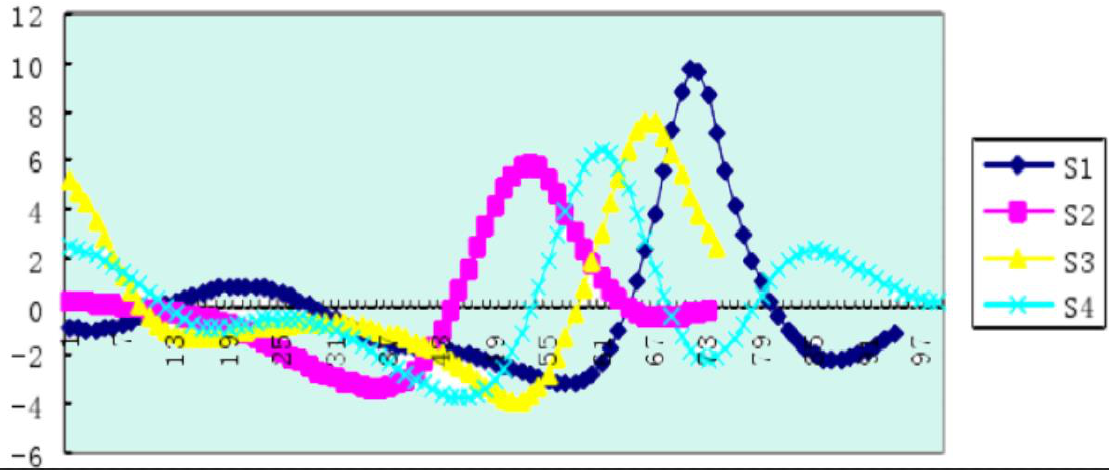
Figure 9. The curve of the angular velocity of the calves of the sample athletes. The abscissa is the time of a swimming cycle, and the ordinate is in radians per second.